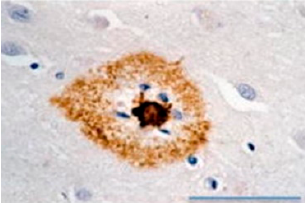
Figure 5. Amyloid-beta (A β ) immunostaining (brown) of an amyloid plaque with a core in a human Alzheimer’s disease case. The dense dark brown core and blue glial nuclei are encircled by a halo of diffuse A β . Scale bars represent 50 μ m [24].